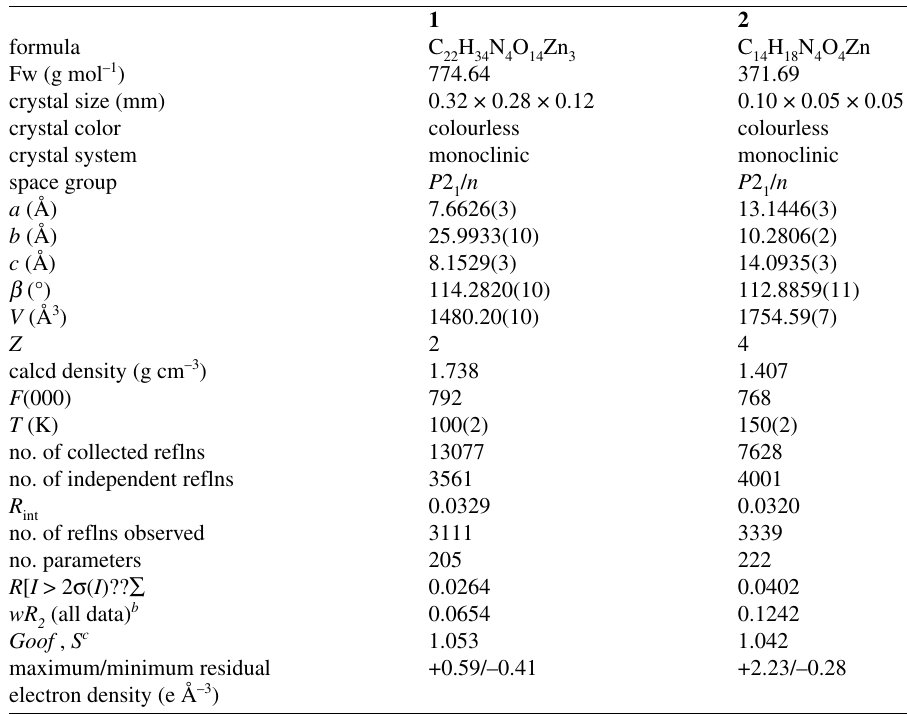
Table 3. Crystallographic data for the X-ray diffraction studies on compounds 1 and 2